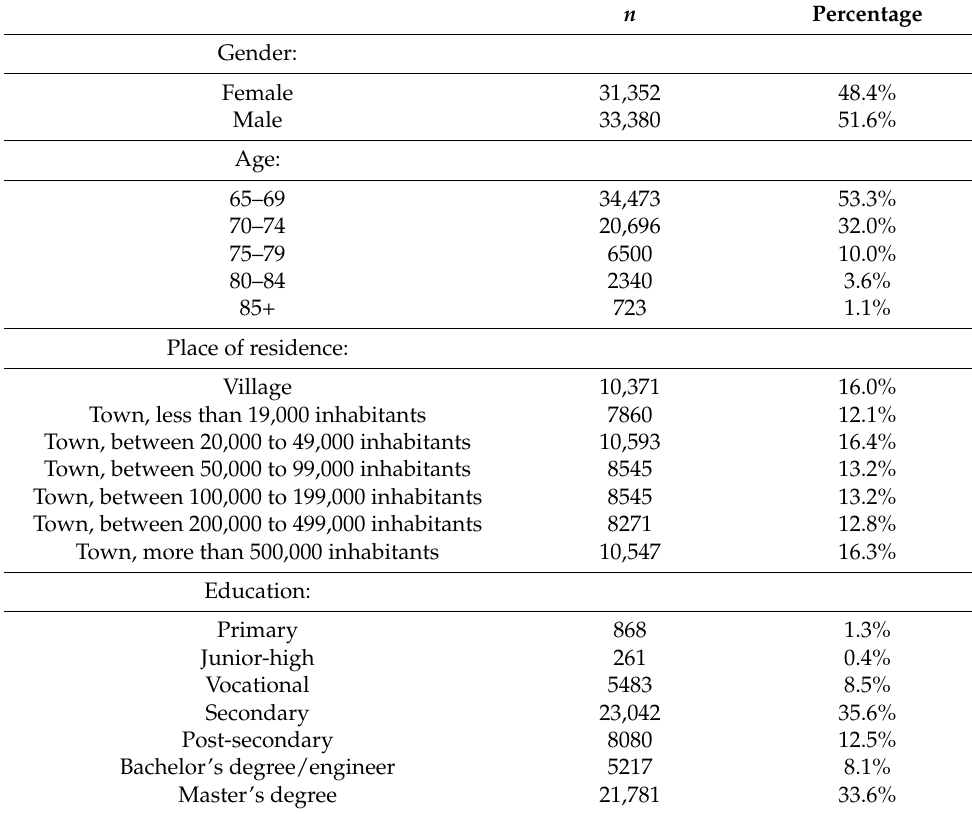
Table 1. Characteristics of the